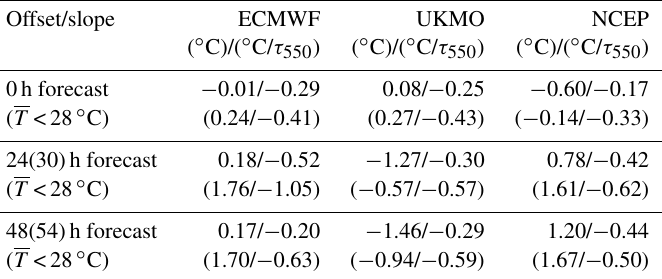
Table 5. Offsets ( ◦ C) and slopes ( ◦ C/ τ 550 ) of MODIS τ 550 vs. the differences between observed (using ground stations as shown in Fig. 7d) and modeled near-surface air temperatures (at 18:00UTC, 30 June 2015) from ECMWF, UKMO, and NCEP model runs. Similar results for stations with monthly mean temperatures ( T ) less than 28 ◦ C are also